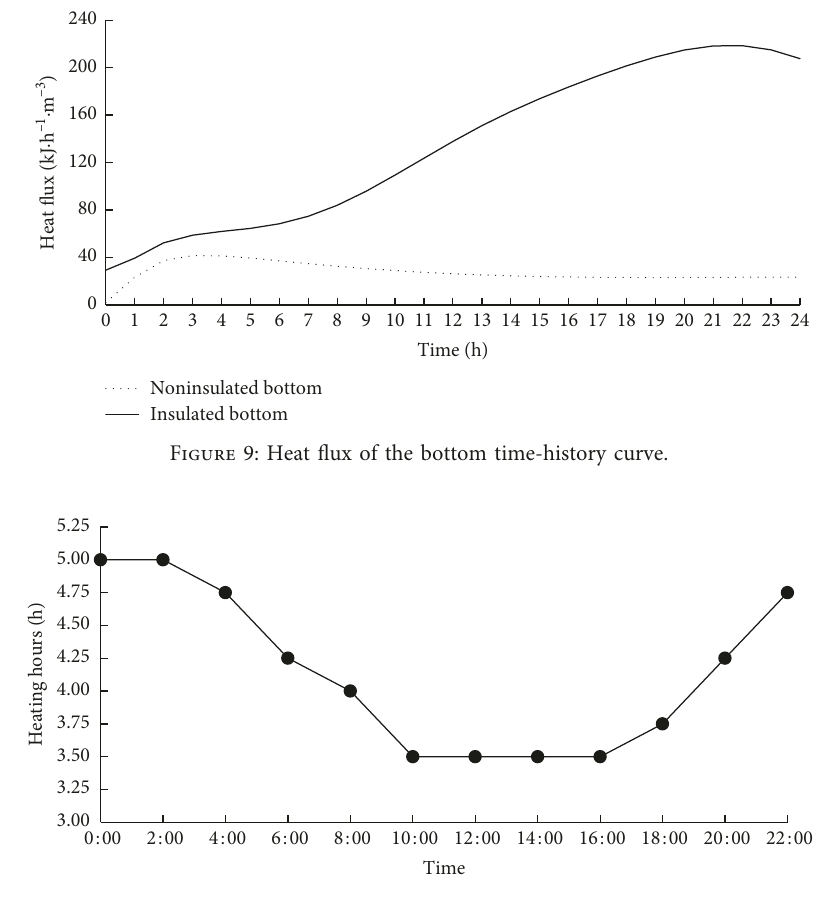
Figure 10: Heating hours at different points in